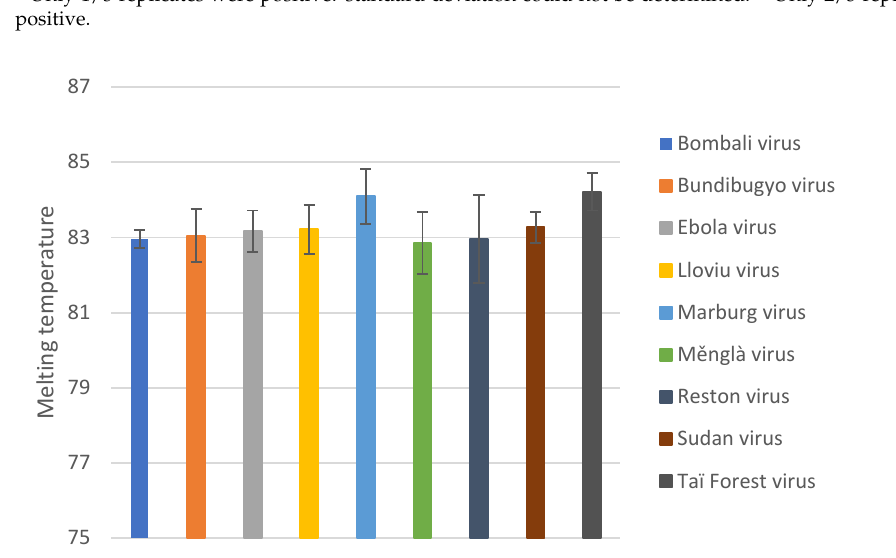
Figure 3. Average melting temperatures of the amplified filovirus standard templates (10 0 –10 9 copies/reaction). Error bars indicate the standard